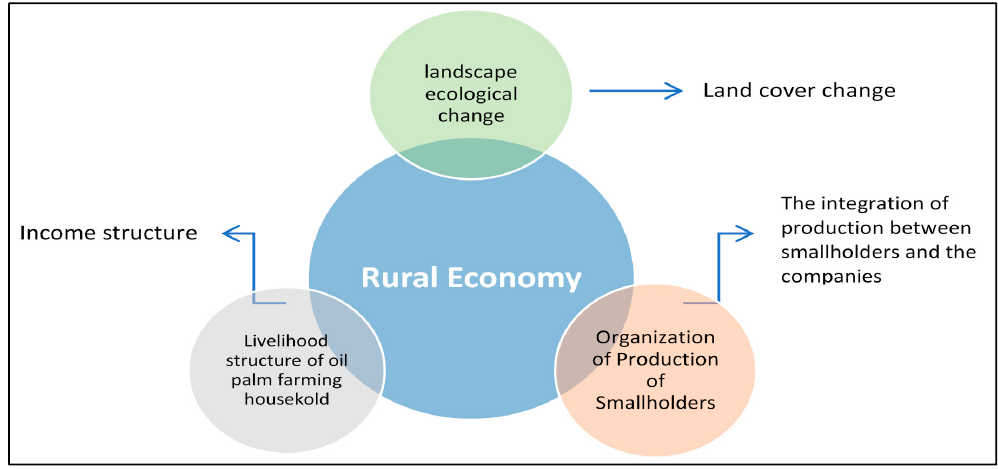
Figure 1. The rural economy and changes in landscape, organization of production, and livelihood.